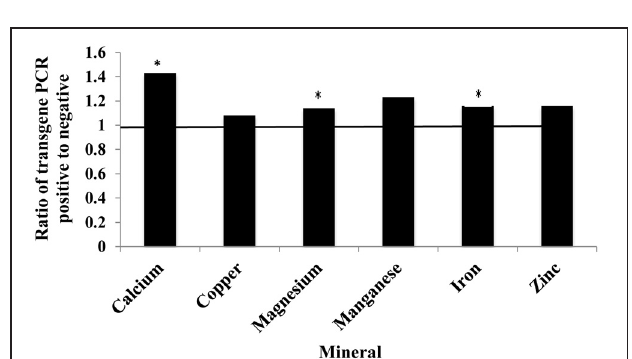
FIGURE 6 | Peakarealeastsquaremeansforthemaizeseedstorageprotein genes (zeins). The horizontal axis shows the HPLC protein peaks, named 1–15 depending on the elution time (see Figure 5 ). Significant differences between